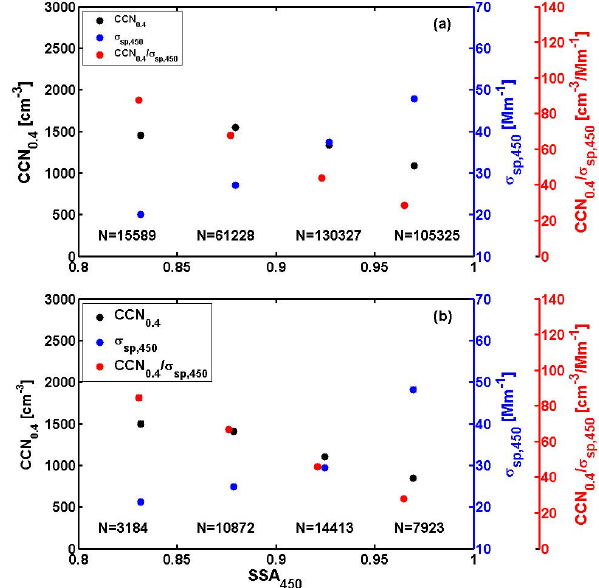
Fig. 8. CCN 0 . 4 concentration, aerosol scattering coefficient and their ratio as a function of SSA at 450nm for all dry particles with D P ≤ 1µm for (a) all values of the extinction Angstrom exponent and (b) values of the extinction Angstrom exponent that fall be- tween 1.6 and 1.8. The sample number in each SSA bin for each case is given in each